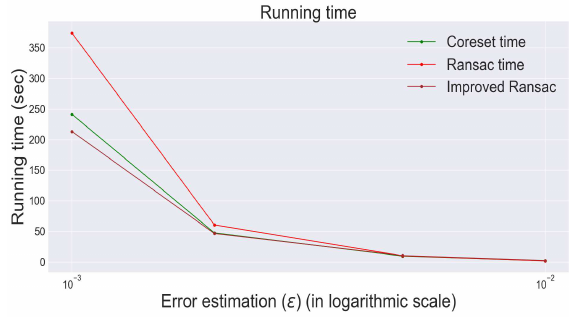
Figure 3. Running time. Experiment on synthetic data sets for several expected value of error factor ( ε ). The measured running time performed for the optimal solution on coreset vs. “RANSAC” algorithm on the full data set and “RANSAC” algorithm on the coreset (“Improved